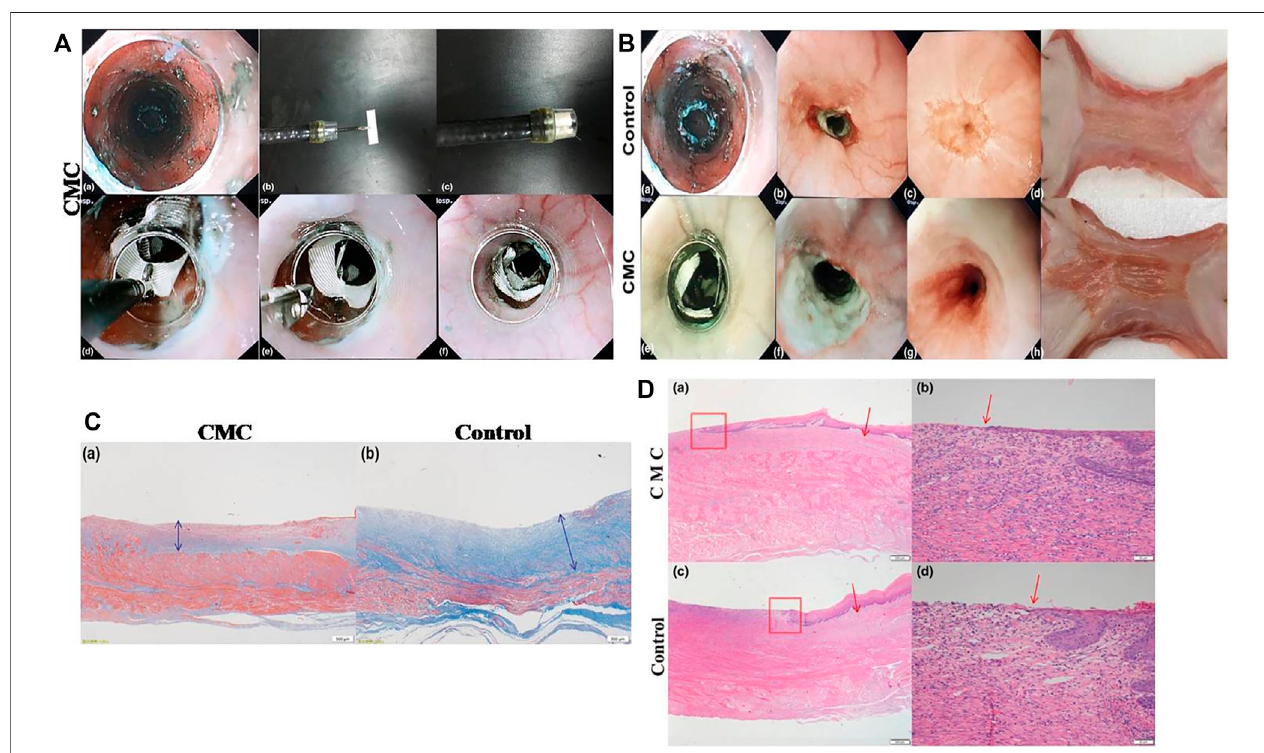
FIGURE 5 | The application of CMC sheet to prevent esophageal stricture after ESD. (A) The process of delivering CMC sheet to the defect of the esophagus. (B) The comparison of the esophagus between the control group and the CMC group. (C) The comparison of fi brosis thickness (blue double-headed arrow) in the submucosa of the esophagus between the CMC-treated group and the control group. (D) The comparison of regenerated epithelial lengths of the esophagus between the CMC-treated group and the control group (red boxes designate the boundary between the regenerated mucosal layer and original mucosa, and red arrows refer to the edge of the regenerating mucosal epithelium). The esophageal mucosal epithelium regeneration in the CMC group was better than that in control group. Reproduced from Tang et al. (2018b). Copyright (2018), with permission from John Wiley and Sons.